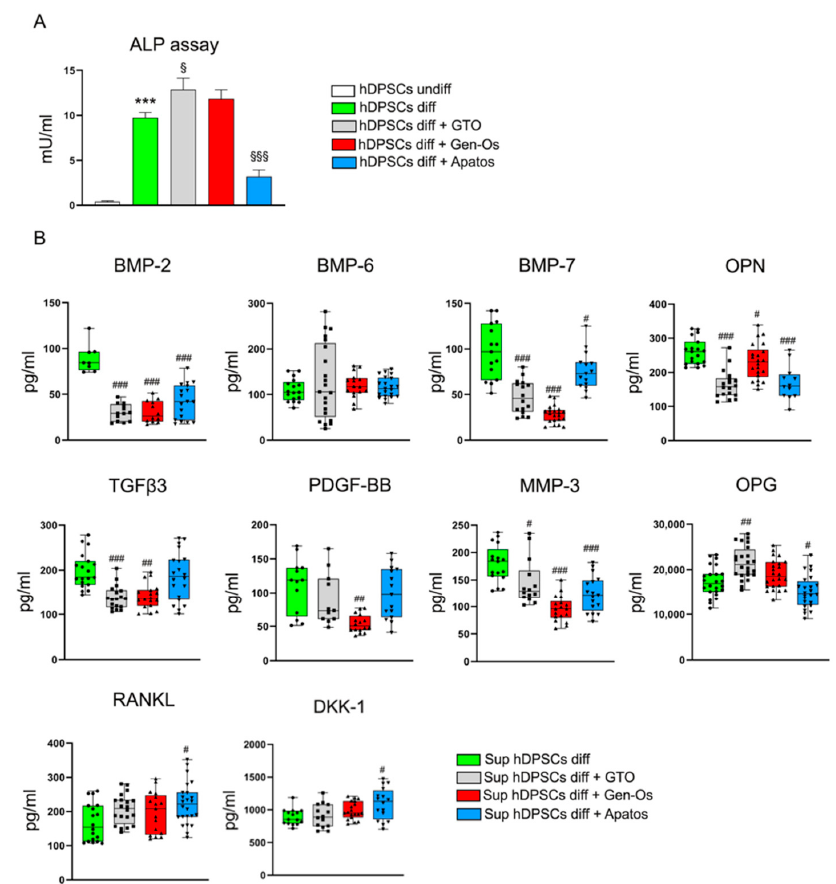
Figure 6. Osteogenic differentiation of hDPSCs treated with BSBs. BSB-treated hDPSCs are cultured under osteogenic differentiation medium for 10 days. ( A ) The osteogenic commitment is evaluated by means of ALP enzymatic activity. Histograms show that, after 10 days of induction, hDPSCs undergo the osteogenic commitment, as revealed by the statistically significant higher levels in ALP activity, compared to hDPSCs undifferentiated (*** p < 0.001 vs. hDPSCs undiff). The effects of BSBs on hDPSCs osteogenic differentiation are highlighted by statistically significant increased ALP activity levels in GTO-treated cells, and lower ALP activity levels in Apatos-treated hDPSCs, both compared to the differentiated control group ( § p < 0.05, §§§ p < 0.001 vs. hDPSCs diff). ( B ) Bone metabolism assay is performed on cell culture media of the differentiated hDPSCs following BSBs treatment. Any statistically significant differences of each target are evaluated by comparing the treated samples to the control group ( # p < 0.05, ## p < 0.01, ### p < 0.001 vs. Sup hDPSCs diff).